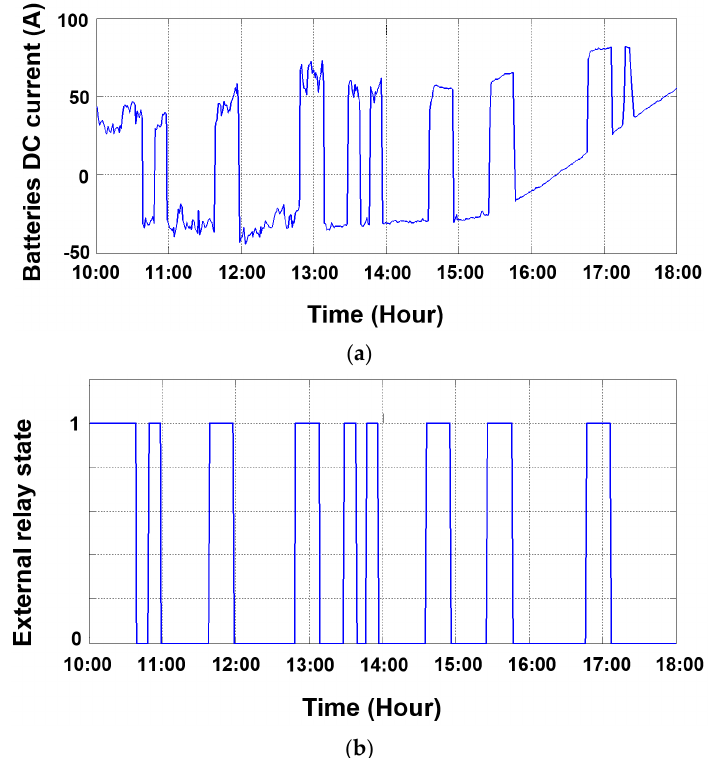
Figure 8. Rule-based EMS: ( a ) ESS DC current and ( b ) grid relay.